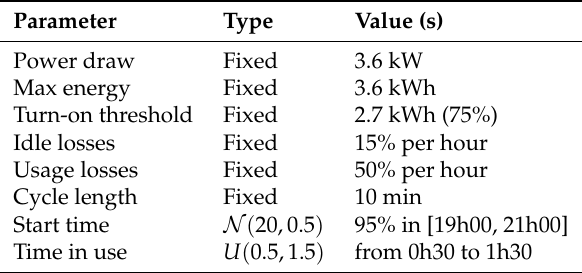
Table 3. Values for the sauna